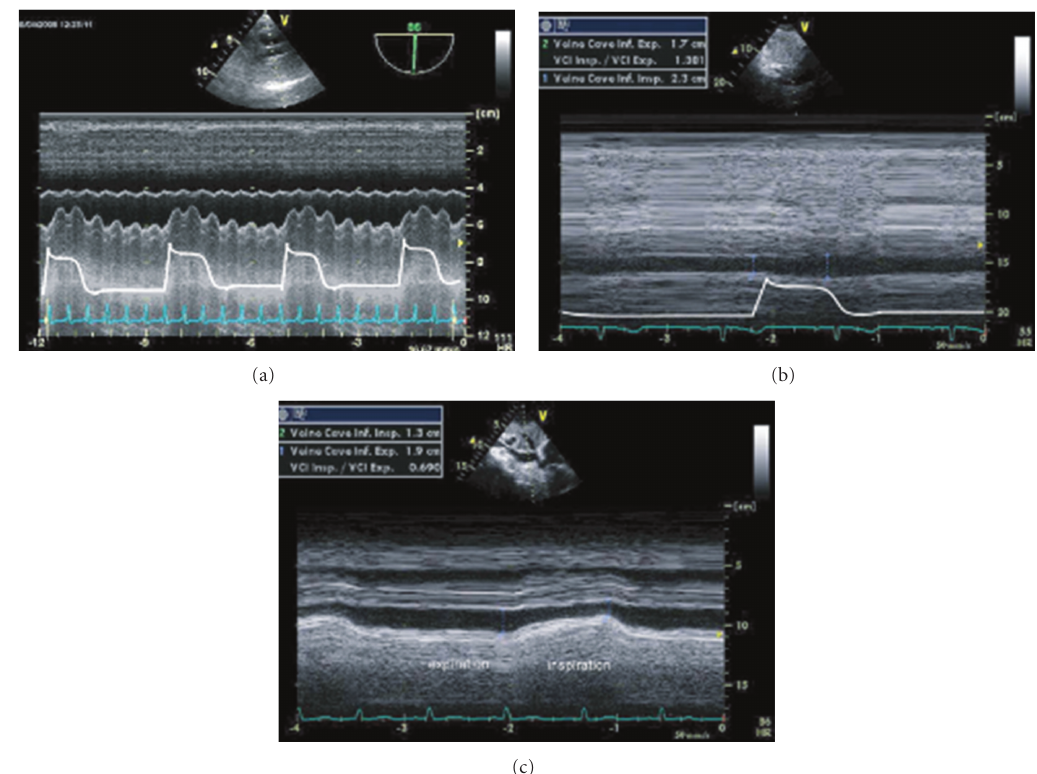
Figure 3: Respiratory vena cava variations in di ff erent circumstances. (a) Significant superior vena cava (SVC) collapsibility recorded with transesophageal echocardiography (TEE). (b) Significant inferior vena cava (IVC) distensibility recorded with transthoracic echocardiography (TTE) in a mechanically ventilated patient. (c) Significant vena cava collapsibility recorded with transthoracic echocardiography (TTE) in a spontaneously breathing patient. Reproduced with permission from Levitov et al. “Critical care Ultrasonography” Mc Graw Hill 2009.